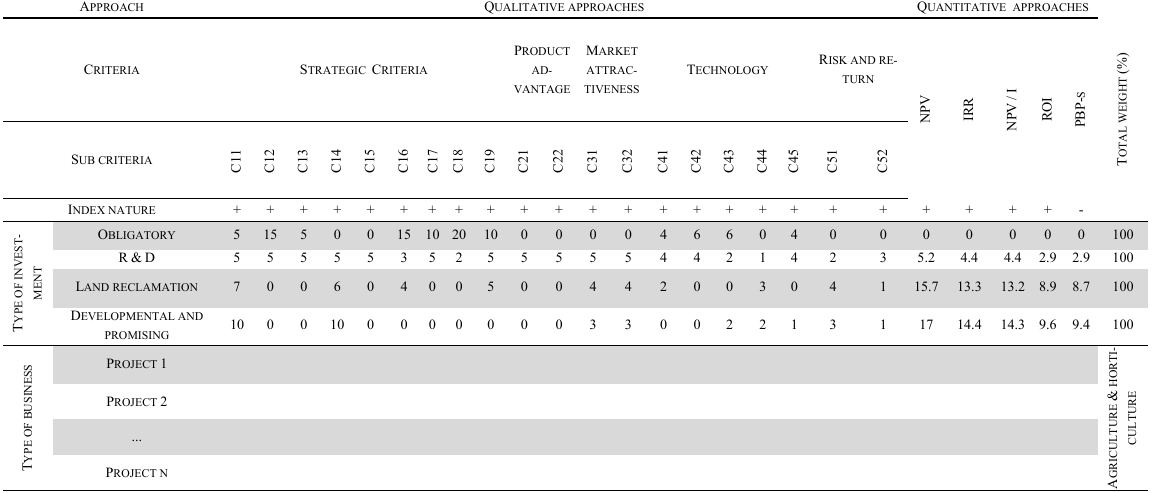
Table 8 Use of TOPSIS and weight obtained from AHP and Delphi methods for ranking